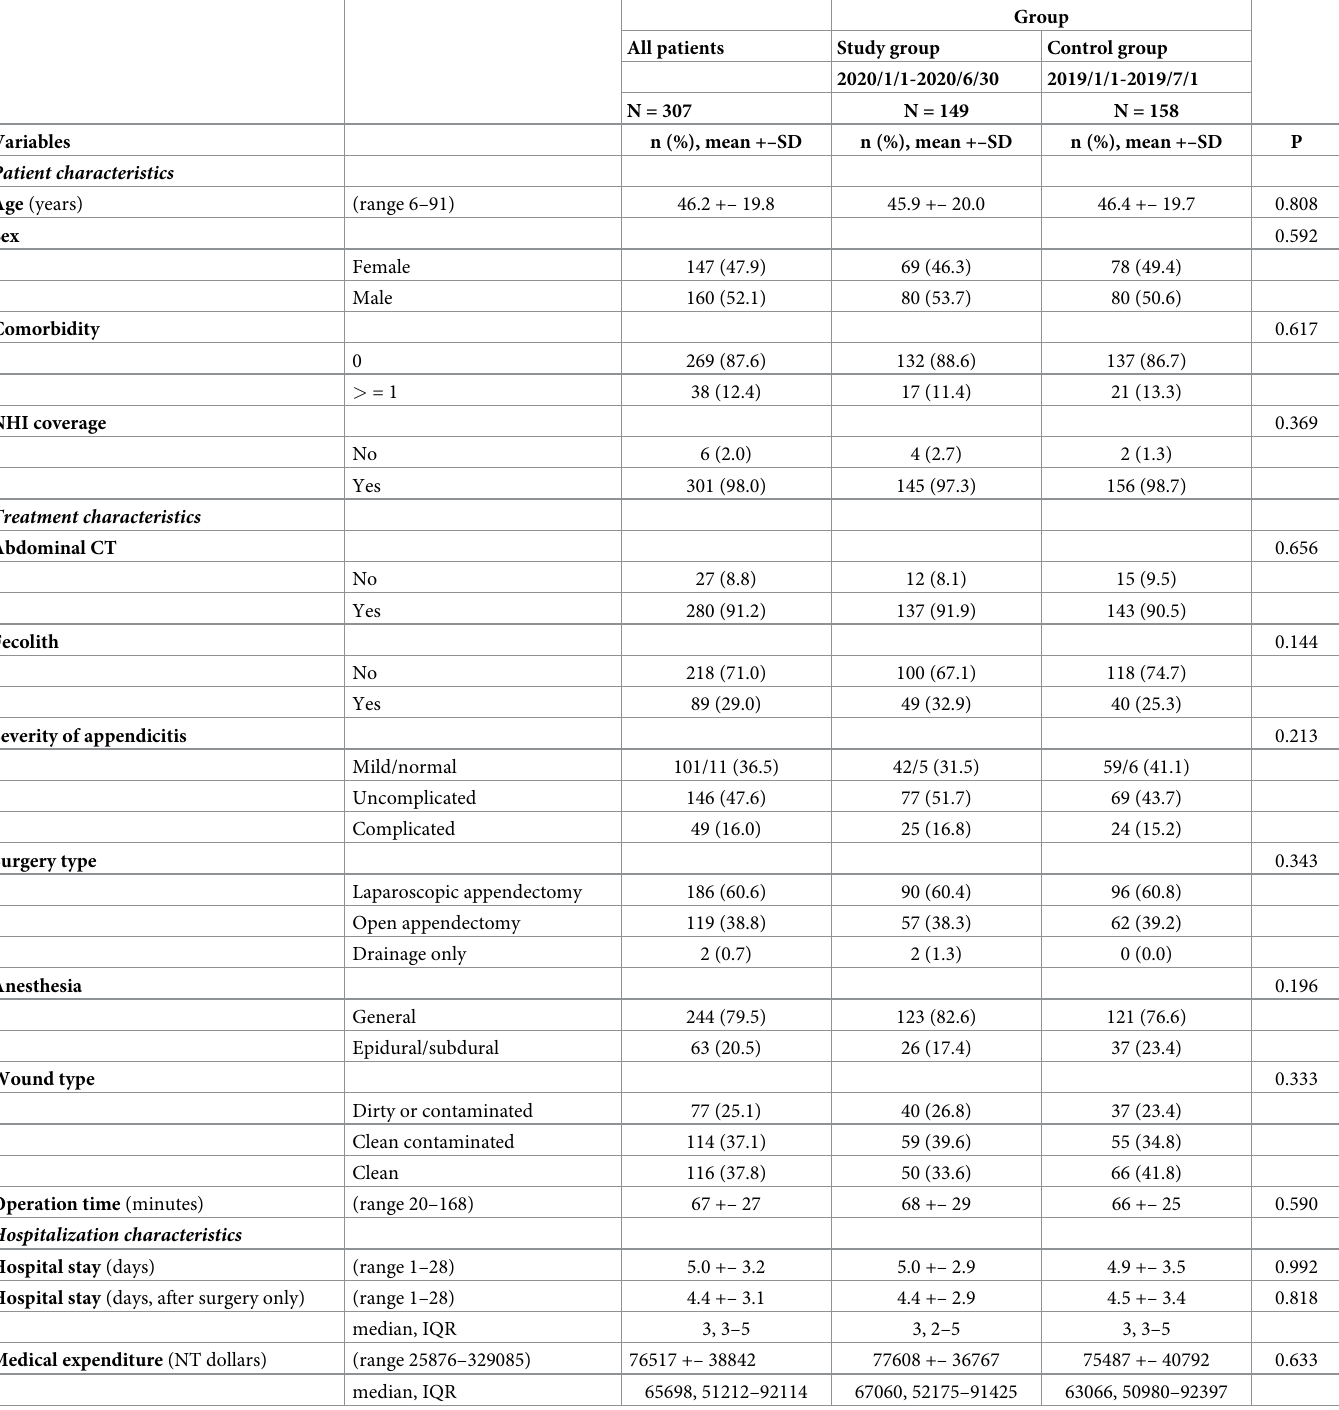
Table 1. Baseline characteristics of patients, treatments, hospitalization for patients undergoing